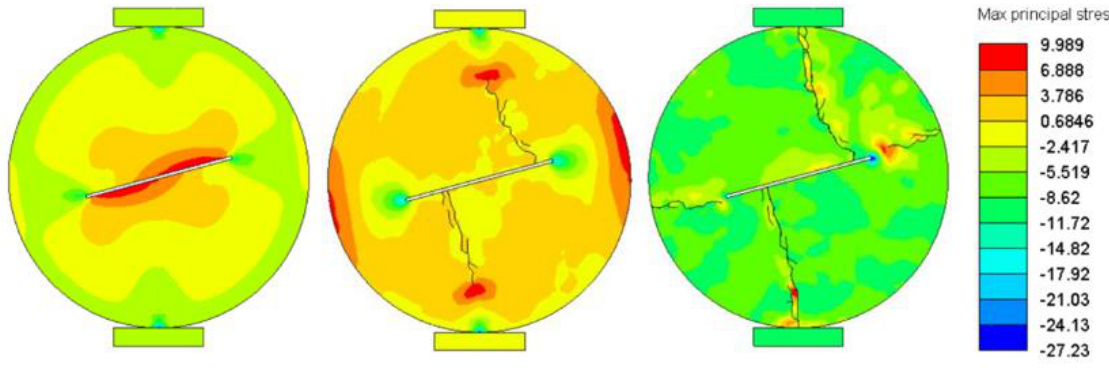
Figure 15. Evolution of maximum principal stress for Brazilian disc with crack of 75° angle.